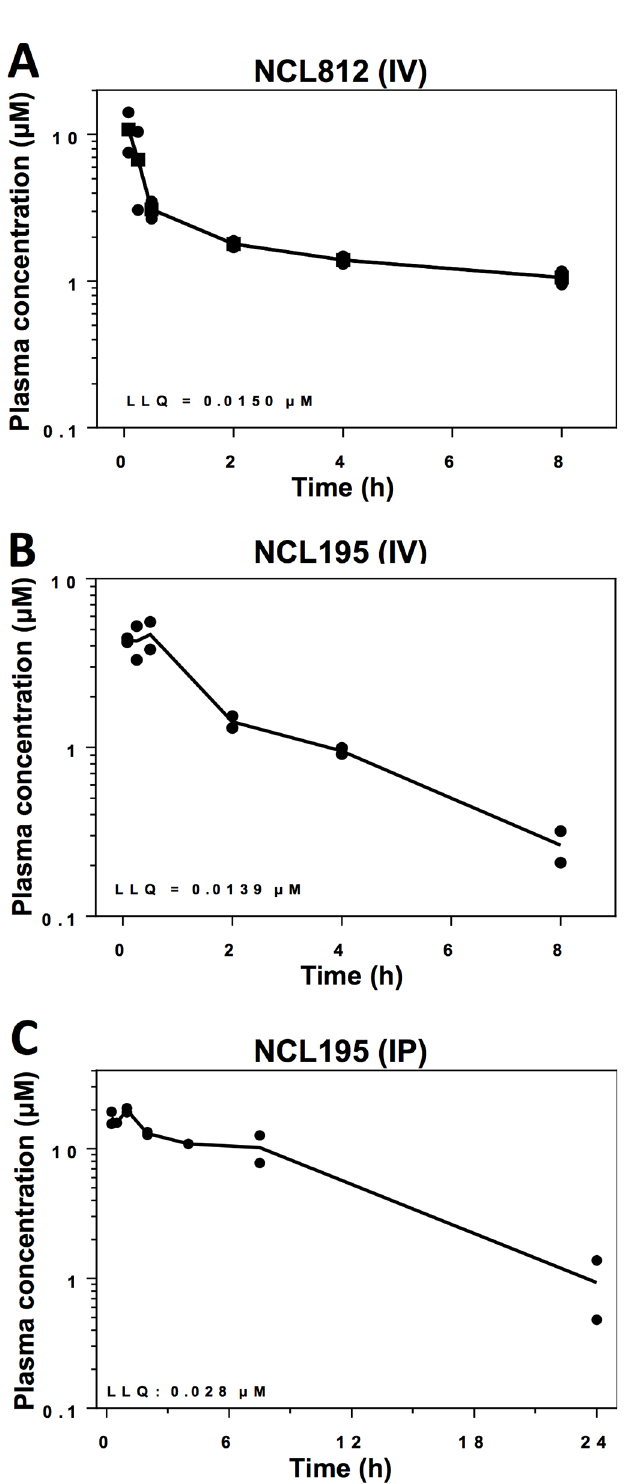
Fig 4. NCL812and NCL195exhibit high plasma concentration and low plasma clearancerates. Pharmacokinetic parametersfor NCL812( A ) and NCL195 ( B ) after IV administration at a dose of 5 mg/kg to male CD1 mice (n = 8 per compound), indicating that both compoundsexhibitedhigh plasma concentrations and long apparentterminal eliminationhalf-lives. ( C ), Pharmacokinetic parameters for NCL195after IP administration at a dose of 43 mg/kg to male CD1 mice (n = 2 per time point), indicatingthat NCL195was